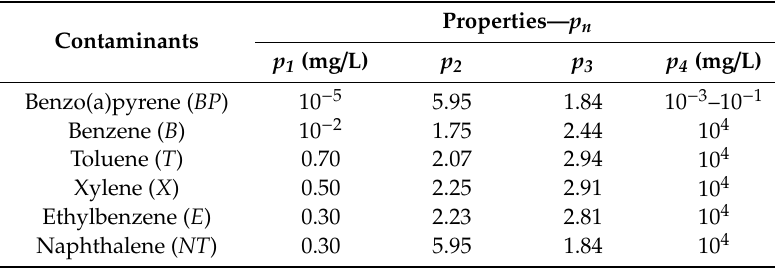
Table 1. Contaminant properties ( p n ).